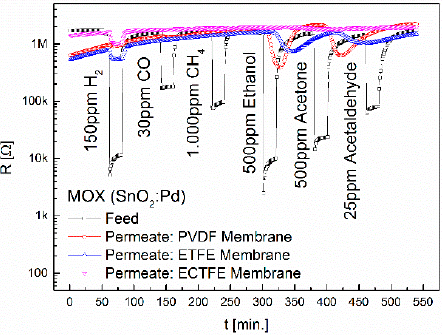
Figure 4. Separation properties of PVDF, ETFE and ECTFE upon exposure to 150 ppm H 2 , 30 ppm CO, 1000 ppm CH 4 , 500 ppm ethanol, 500 ppm acetone and 25 ppm acetaldehyde. The diameter of the membranes is 6.4 mm.